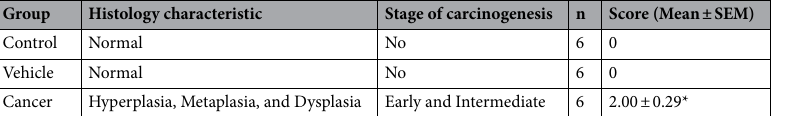
Table 1. Histopathology score of lung tissue after 15 weeks of treatment. *Significant difference ( P < 0.05) between cancer with vehicle and control groups.